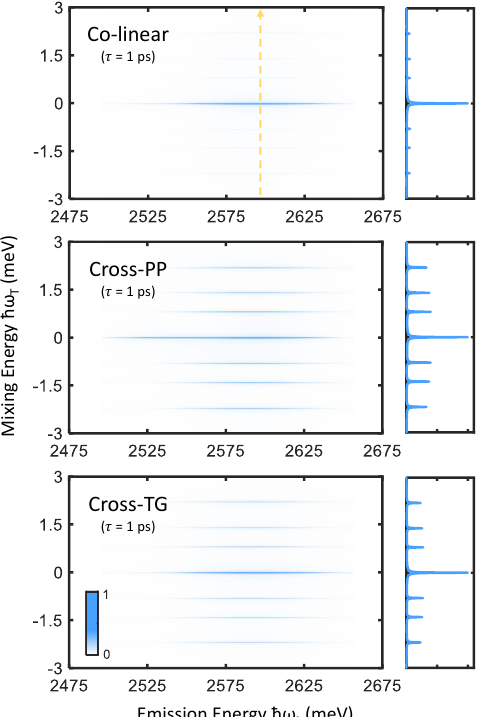
Figure 6. Zero-quantum spectra simulated for colinear ( top ), cross-PP ( middle ), and cross-TG ( bottom ) excitation and τ = 1 ps. Vertical slices taken along ¯ h ω t = 2590 meV (indicated by the dashed yellow arrow) are plotted to the right of each spectrum, which emphasize the effect of excitation polarization scheme on the intraband coherence